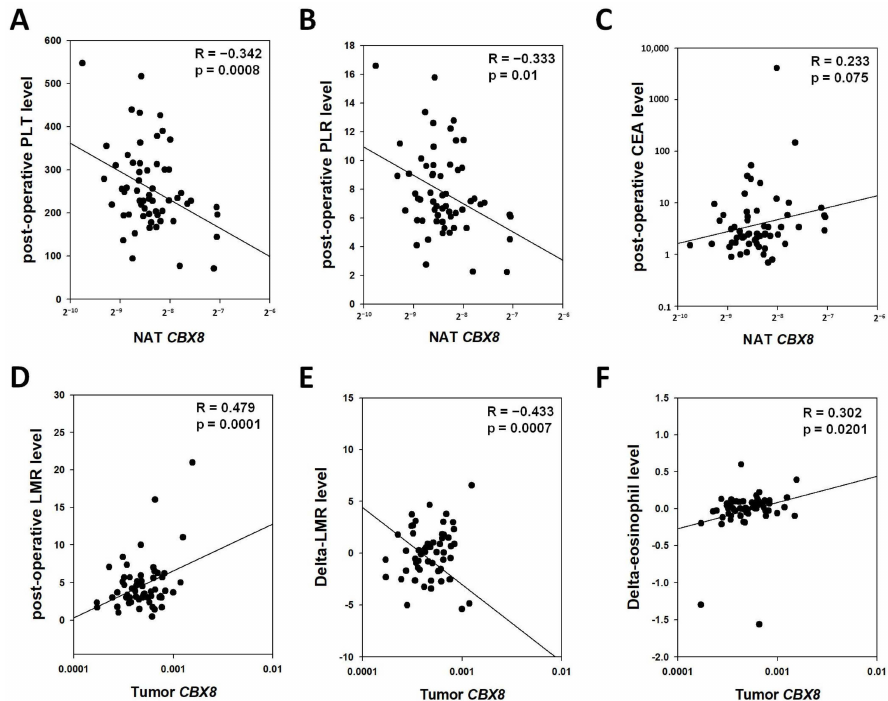
Figure 3. Correlation between NAT or CRC CBX8 gene expression and blood immune cell profiles in CRC patients. ( A , B ) NAT CBX8 level was inversely correlated with level of ( A ) platelets (PLT) and ( B ) platelet to lymphocyte ratio (PLR) in post-operative blood of CRC patients. ( C ) NAT CBX8 level showed a positive trend with level of post-operative CEA. ( D ) Tumor CBX8 level was positively correlated with post-operative LMR level. ( E , F ) Tumor CBX8 level was inversely and positively correlated with dymamic changes (post-operative minus pre-operative) in ( E ) LMR level and ( F ) eosinophil level,